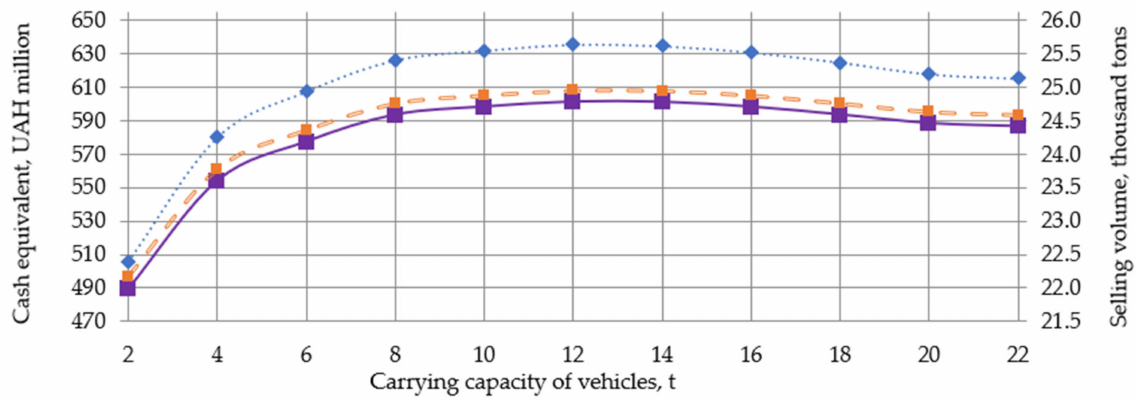
Figure 13. Change of the generalized distribution utility index, profit and selling goods depending on the carrying capacity of vehicles: —the generalized distribution utility index in consumer- driven logistics scenario, UAH; —selling volume via supply scenario, thousand ton.; — profit of supplying scenario,